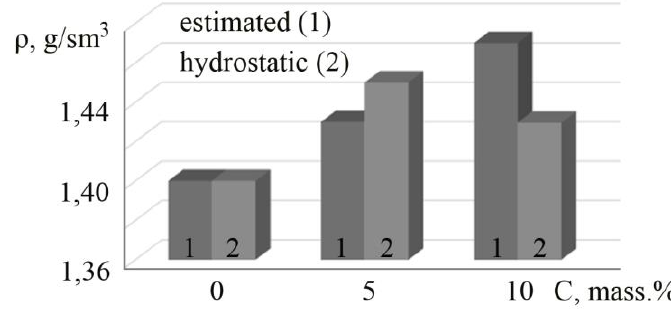
Fig. 5. Dependence of calculated and hydrostatic density of polyethylene terephthalate on the content of basalt